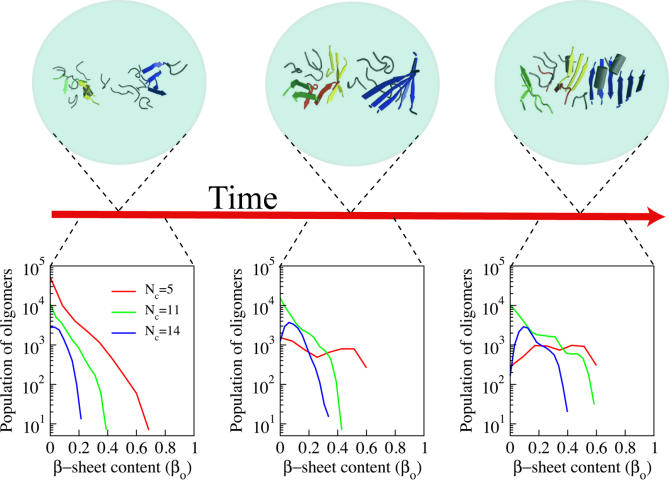
Time Dependence of the Population of Aβ16–22 OligomersThe population P(Nc) was calculated as the sum over all the oligomers of a given size (Nc = 5 (red), 11 (green), and 14 (blue)) in a specific time window and in all the 100 independent simulations. We show P as a function of the β sheet content as defined by the local-order parameter βo. Each window corresponds to a different time point along the simulation. At early stages (left), configurations are highly disordered; at intermediate stages (centre), ordered structures start to appear; at late stages (right), the structures are rather well ordered.